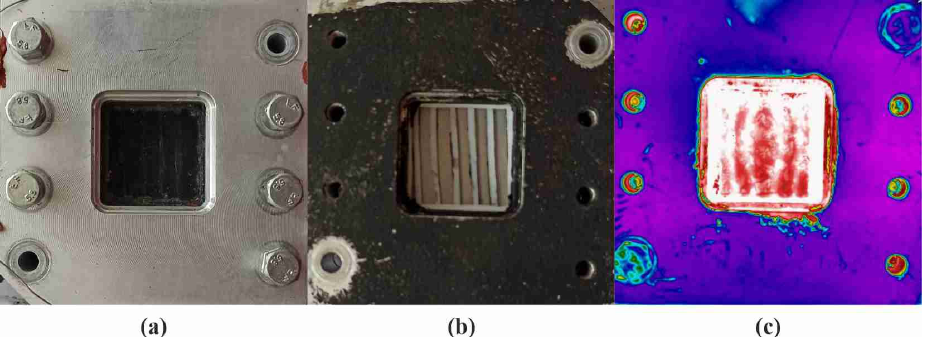
Figure 2. Views of the test section: ( a ) from the infrared thermography temperature measurements side and ( b ) from two-phase flow patterns observation side; ( c ) thermographic view of the test section, corresponding to ( a ).